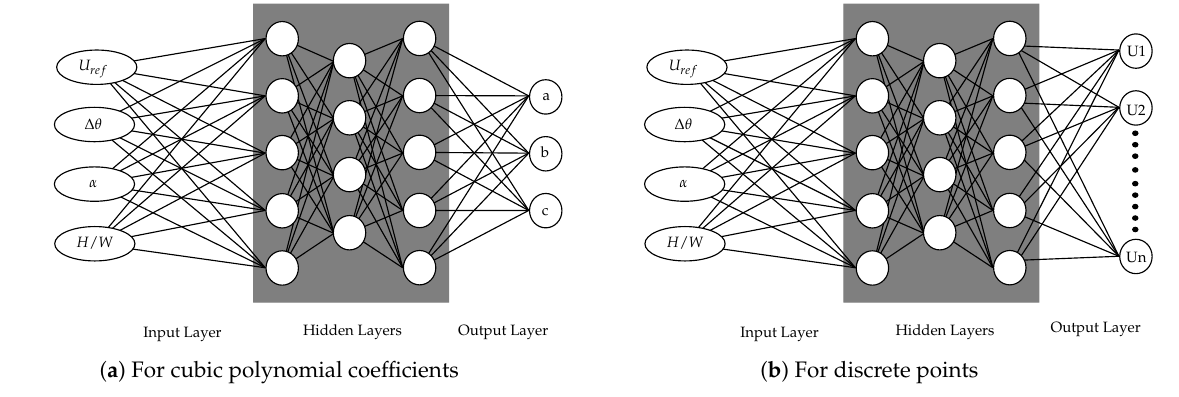
Figure 12. ANN model architectures.